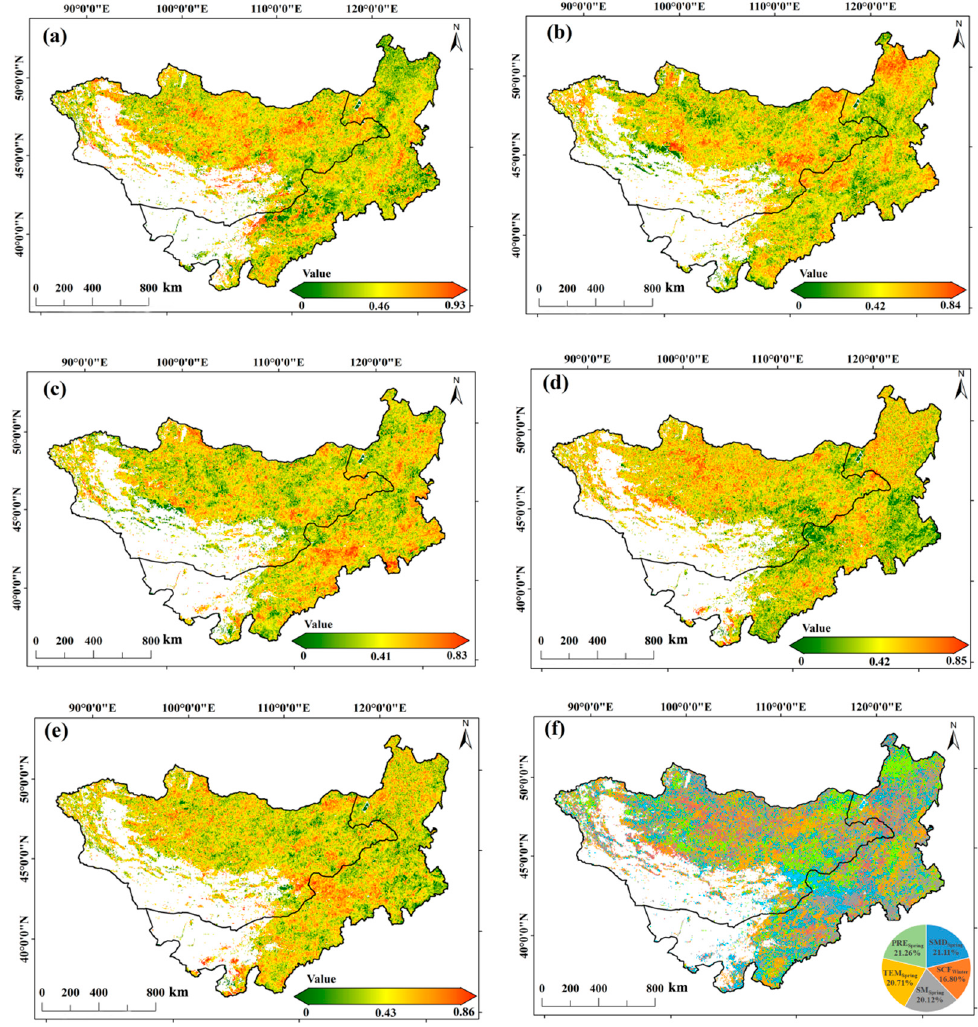
Figure 4. Different factors of 2001–2019 grey relation analysis: ( a ) SOS NPP –TEM Spring ; ( b ) SOS NPP – PRE Spring ; ( c ) SOS NPP –SM Spring ; ( d ) SOS NPP –SCF winter ; ( e ) SOS NPP –SMD Spring; ( f ) spatial importance